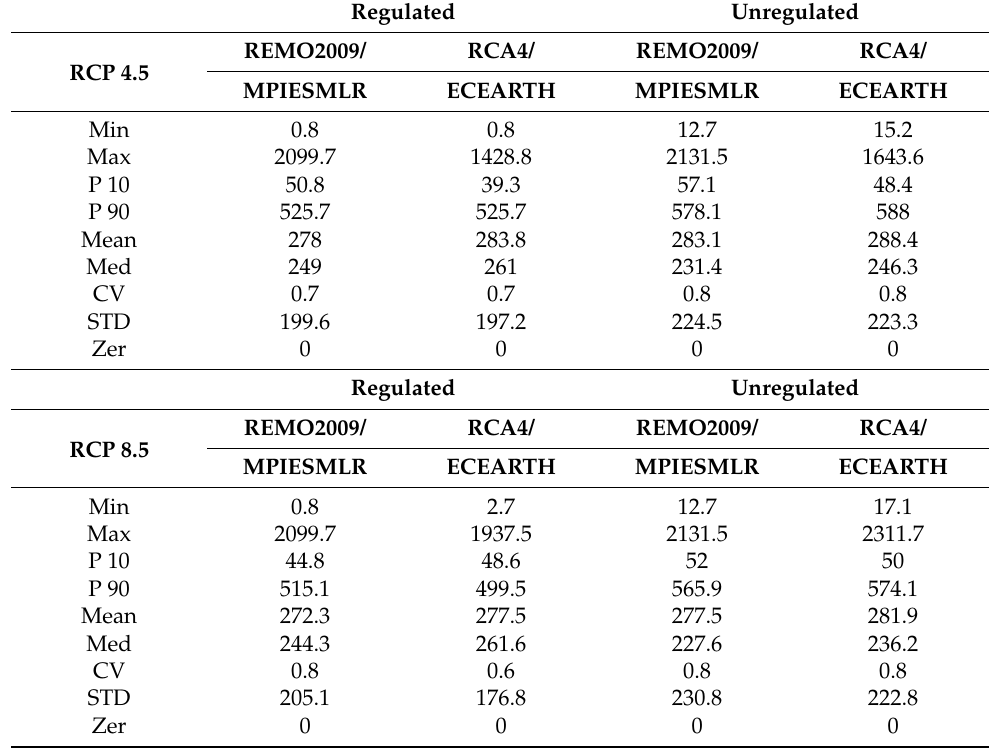
Table 5. Comparison of descriptive statistics between unregulated and regulated streamflow condi- tions, forced by future climate scenarios derived from climate ensembles and the E HYPE hydrological model. P: percentile, Med: median, CV: coefficient of variation, STD: standard deviation, Zer: number of zero flow